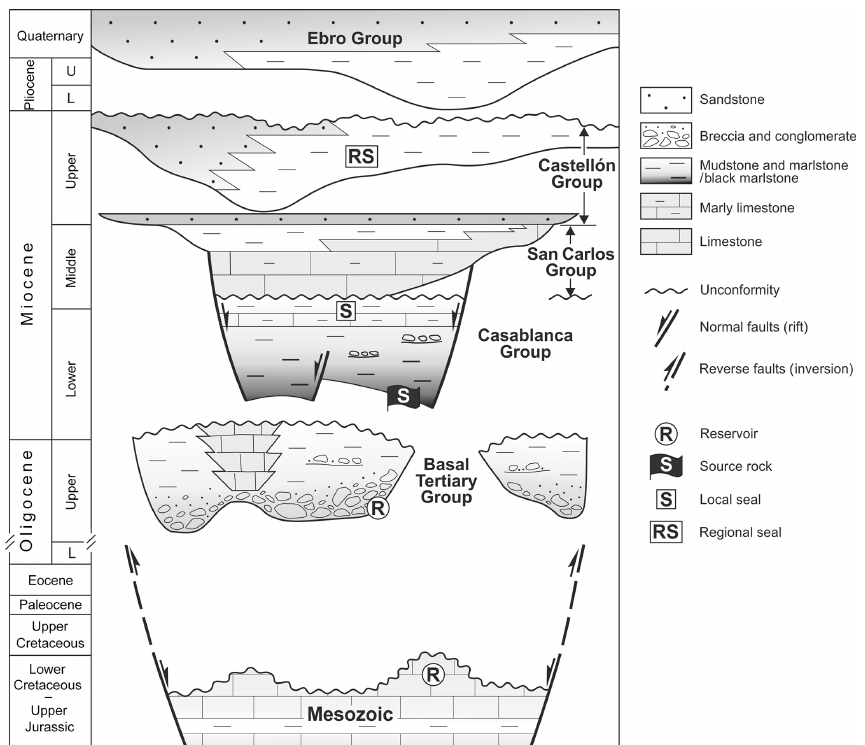
Figure 2. Chronostratigraphic diagram of the study area showing the age and main lithologies of the infill of the Valencia Trough in the Montanazo and Lubina field area. The reservoir, source and seal rocks are also